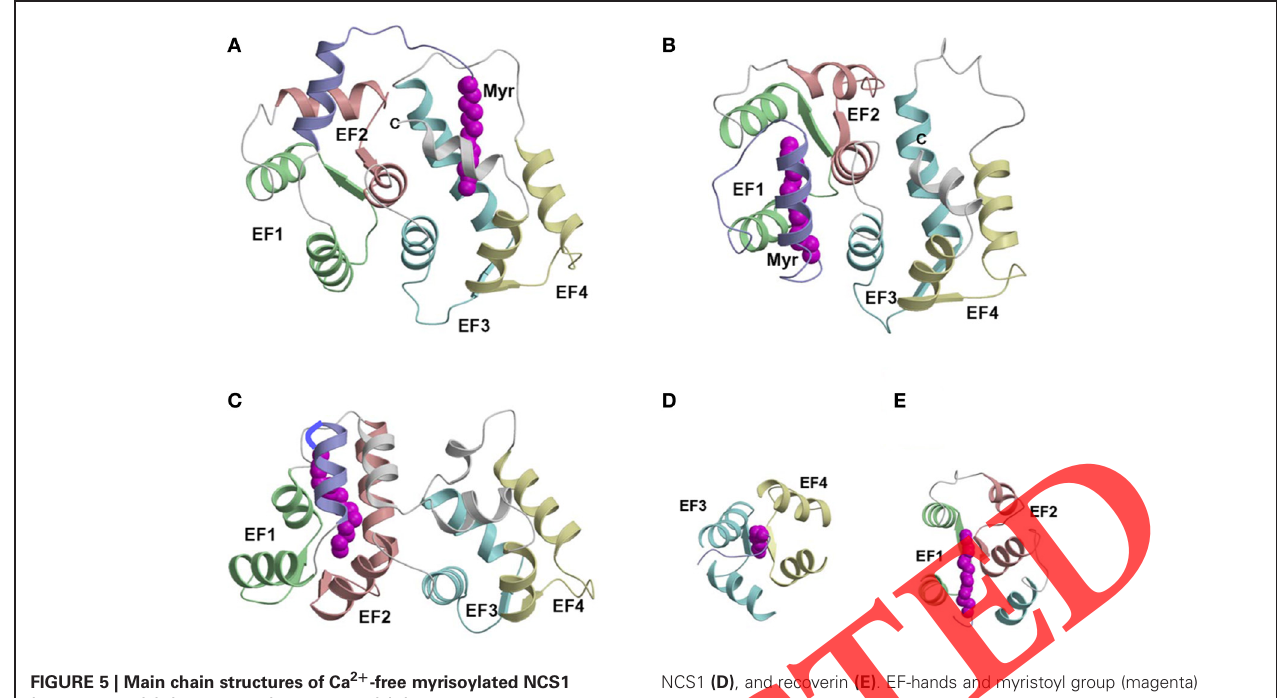
NCS1 (D) , and recoverin (E) . EF-hands and myristoyl group (magenta) are colored as defined in Figure 1 . Adapted from and originally published by Lim et al.